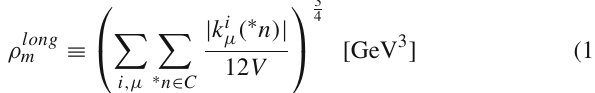
β = 5 . 8124 , 5 . 8457 , 5 . 9256 , and6.0000.Therightpanelshowsthedis- cretization effects on the numerical results of three-dimensional physi- 3 = 2 . 3489 , 3 . 3106 , 4 . 7137 , and 5.5677 [fm 3 4 cal volumes V phys